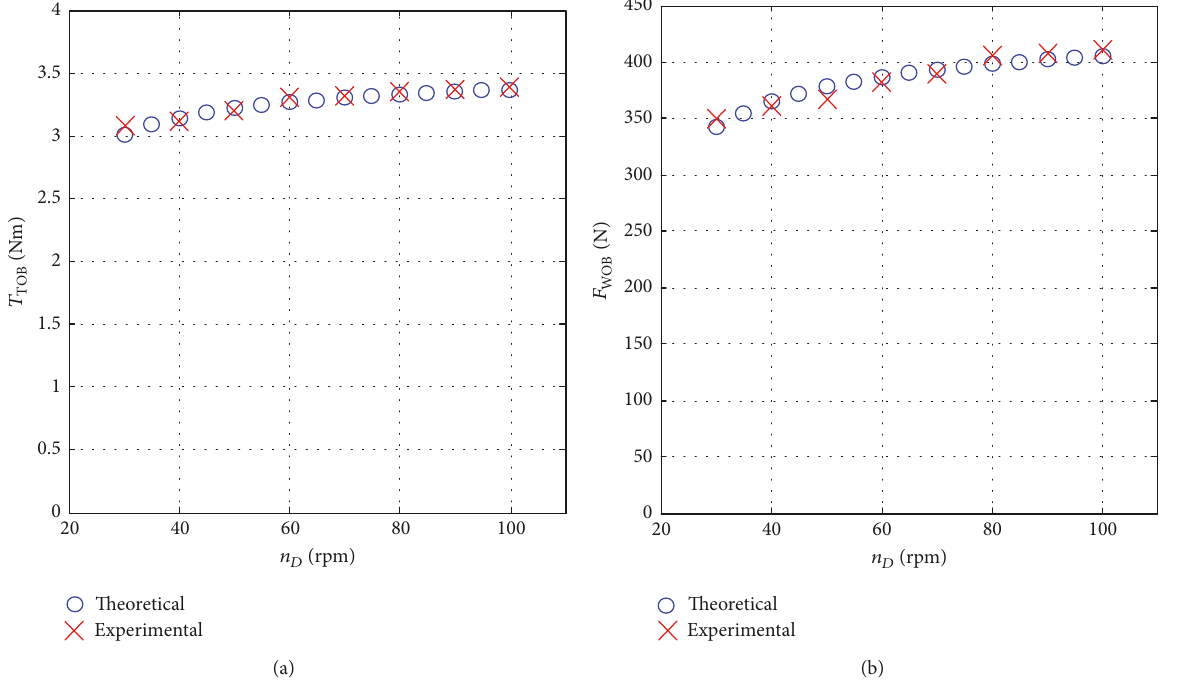
Figure 14: Trend of the LRCB load in rotary-percussive drilling with the increased rotational velocity and fixed PPR.